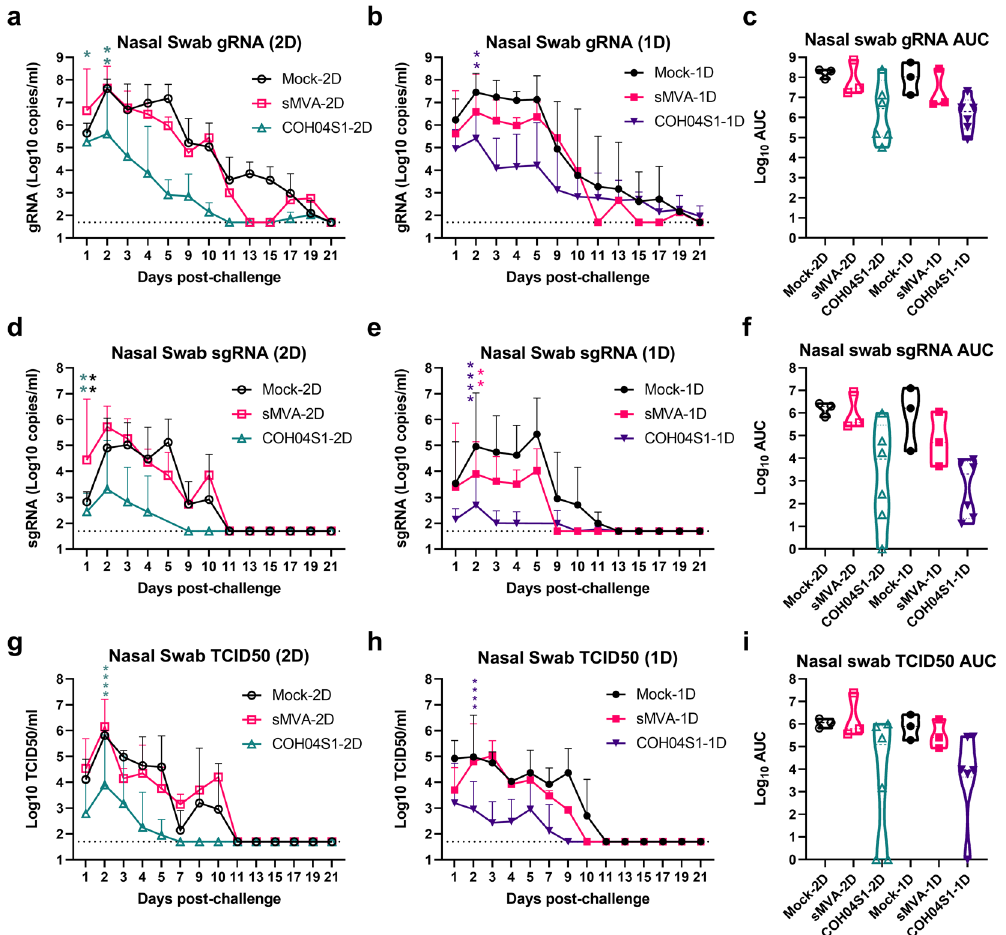
Fig. 5 Nasal swab viral loads in COH04S1-vaccinated NHP after SARS-CoV-2 challenge. SARS-CoV-2 genomic RNA (gRNA; a – c ) and subgenomic RNA (sgRNA; d – f ) copies and TCID50 infectious virus titers ( g – i ) were measured at the indicated days post challenge in nasal swab samples of COH04S1-2D and COH04S1-1D-vaccinated NHP and mock-vaccinated and sMVA vector control animals. Lines represent geometric means + geometric s.d. Dotted lines represent lower limit of detection. Two-way ANOVA followed by Sidak ’ s multiple comparison test was used. Panels c , f , and i show viral loads by area under the curve (AUC). Violin plots show value ranges with median values (dashed line) and quartiles (dotted line). AUC = 0 was indicated as 1. One-way ANOVA followed by Tukey ’ s multiple comparison test was used. *0.05 < p < 0.01, **0.01 < p < 0.001, ***0.001 < p < 0.0001, **** p <